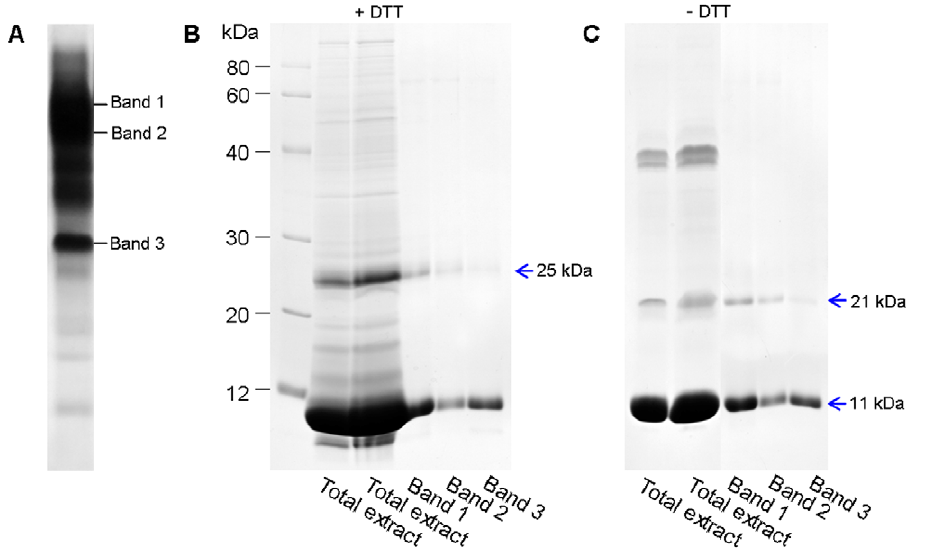
Figure 5. Identification of subunit compositions of lectins in P.ternata tubers. A , native gel, total tuber proteins. B , total tuber proteins and purified Bands 1–3 were resolved by SDS-PAGE under reducing conditions (with DTT). C , total tuber proteins and purified Bands 1–3 were resolved by SDS-PAGE under reducing conditions (without DTT).